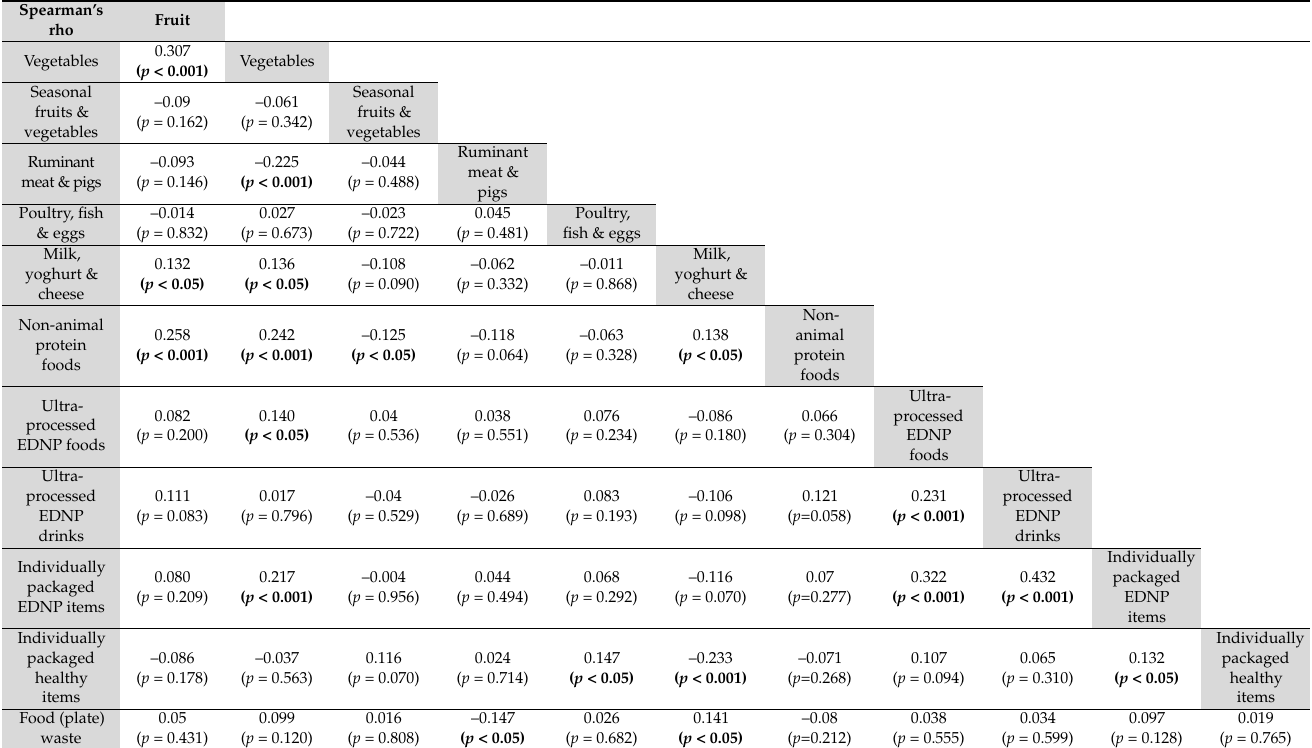
Table 4. Relationship between components of the HSDI at baseline, assessed using Spearman’s correlation coefficient ( n =